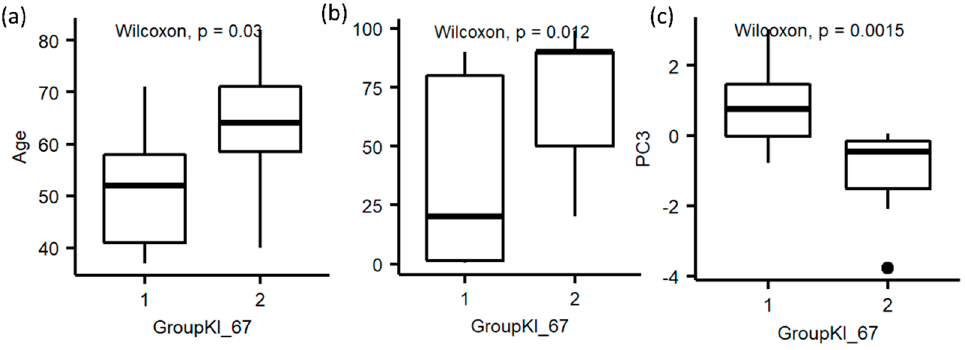
Figure 6. Box plots for high and low values of Ki-67 (i.e., Class 1 and 2). ( a ) Age; ( b ) Progesterone status; ( c ) PC3 from the quantile status; ( c ) PC3 from the quantile dataset. status; ( c ) PC3 from the quantile dataset.